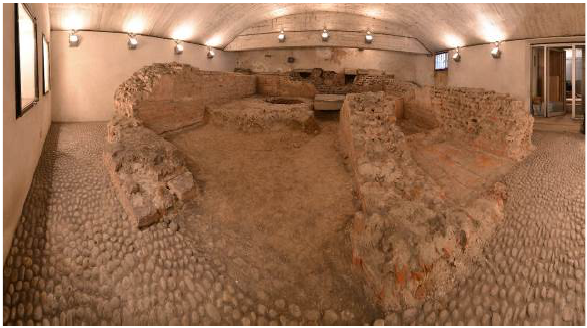
Figure 11. Panoramic image of the archaeological funerary structure in via Santa Valeria